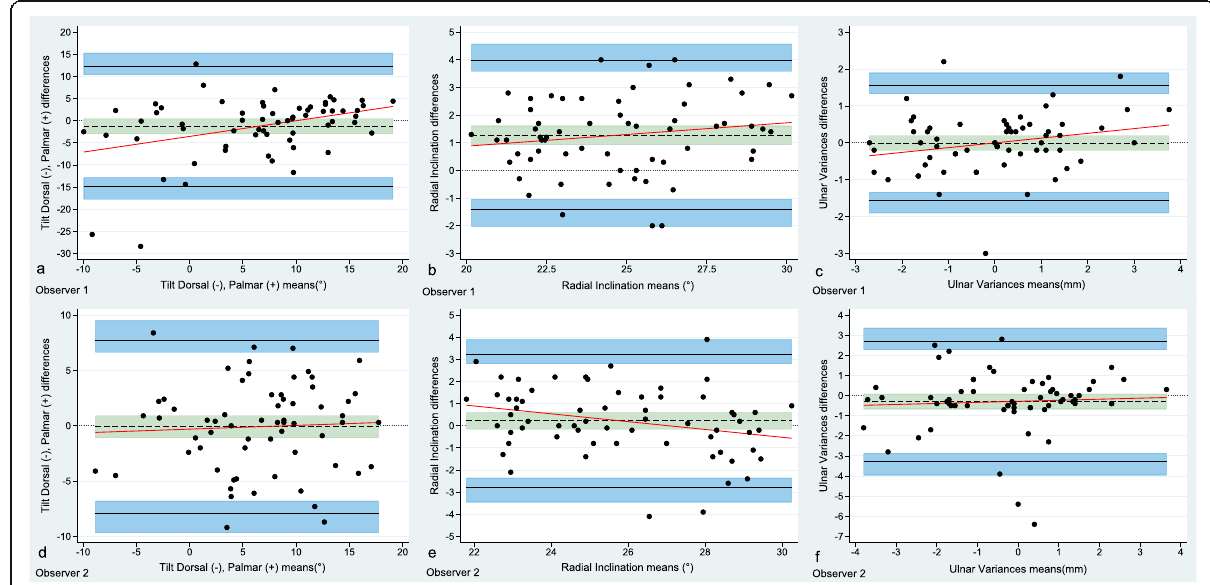
Fig. 6 Bland-Altman plots displaying intraobserver agreement (63 images). Observer 1 ( a – c ) and observer 2 ( d – f ). Differences between 1st and 2nd measurement plotted against the mean of 1st and 2nd